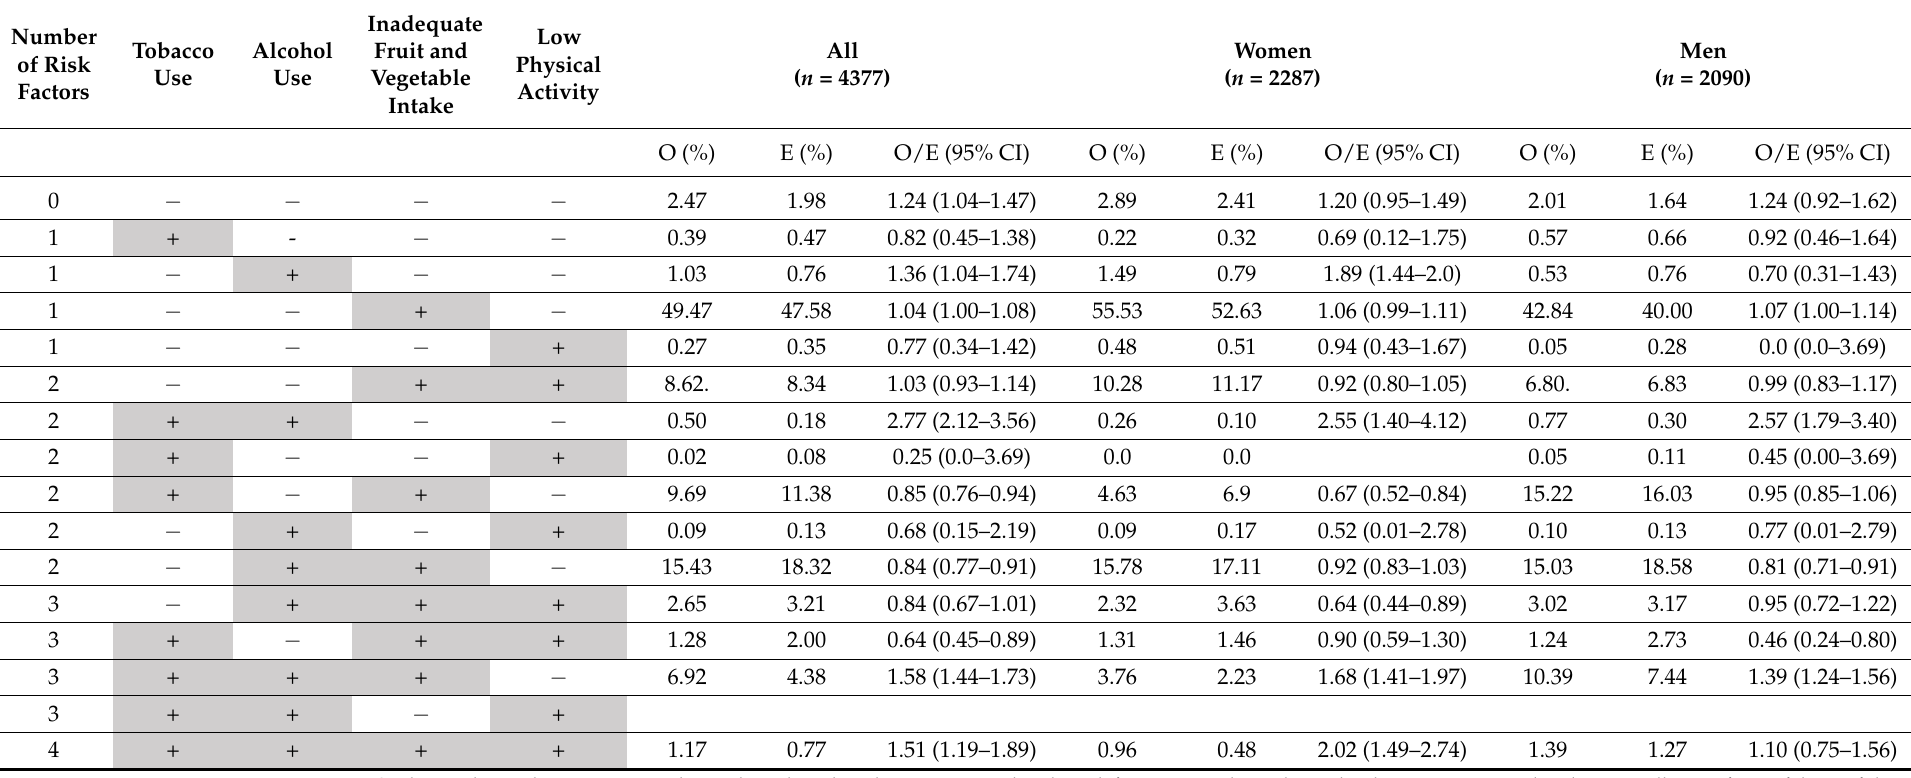
Table 4. Clustering of lifestyle risk